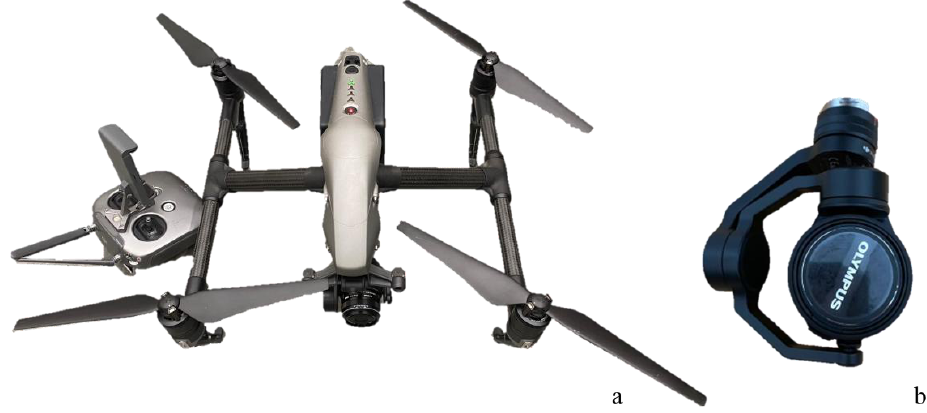
Figure 5. DJI Inspire II UAS: (a) DJI Inspire II drone, (b) DJI Zenmuse X5S camera and an Olympus M.Zuiko